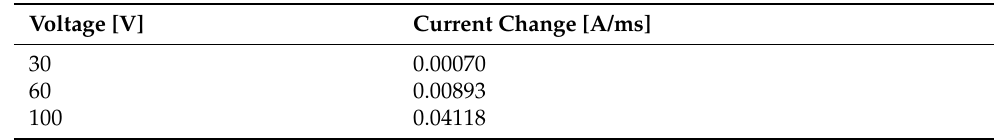
Table 2. Current changes over